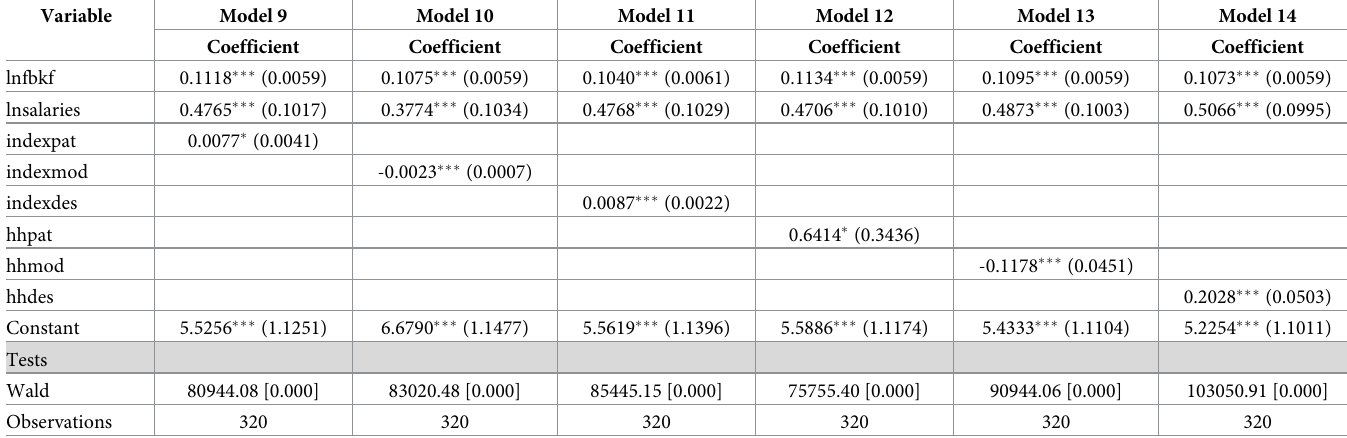
Table 6. Fixed effects estimates with FGLS heterskedasticity correction.